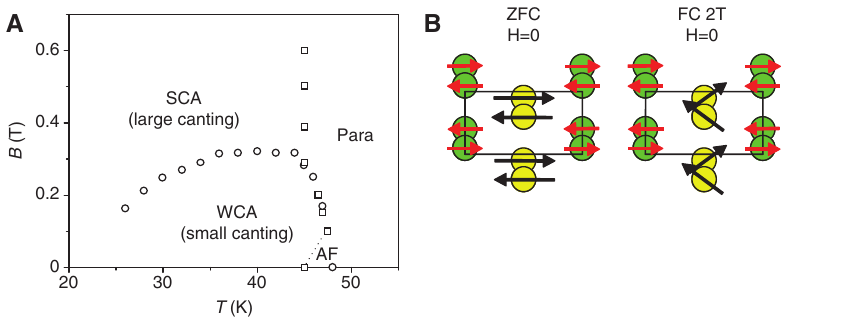
(OH) (C H O ) and (B) comparison of magnetic structures at zero field observed at 10 K after 2 2 8 4 4